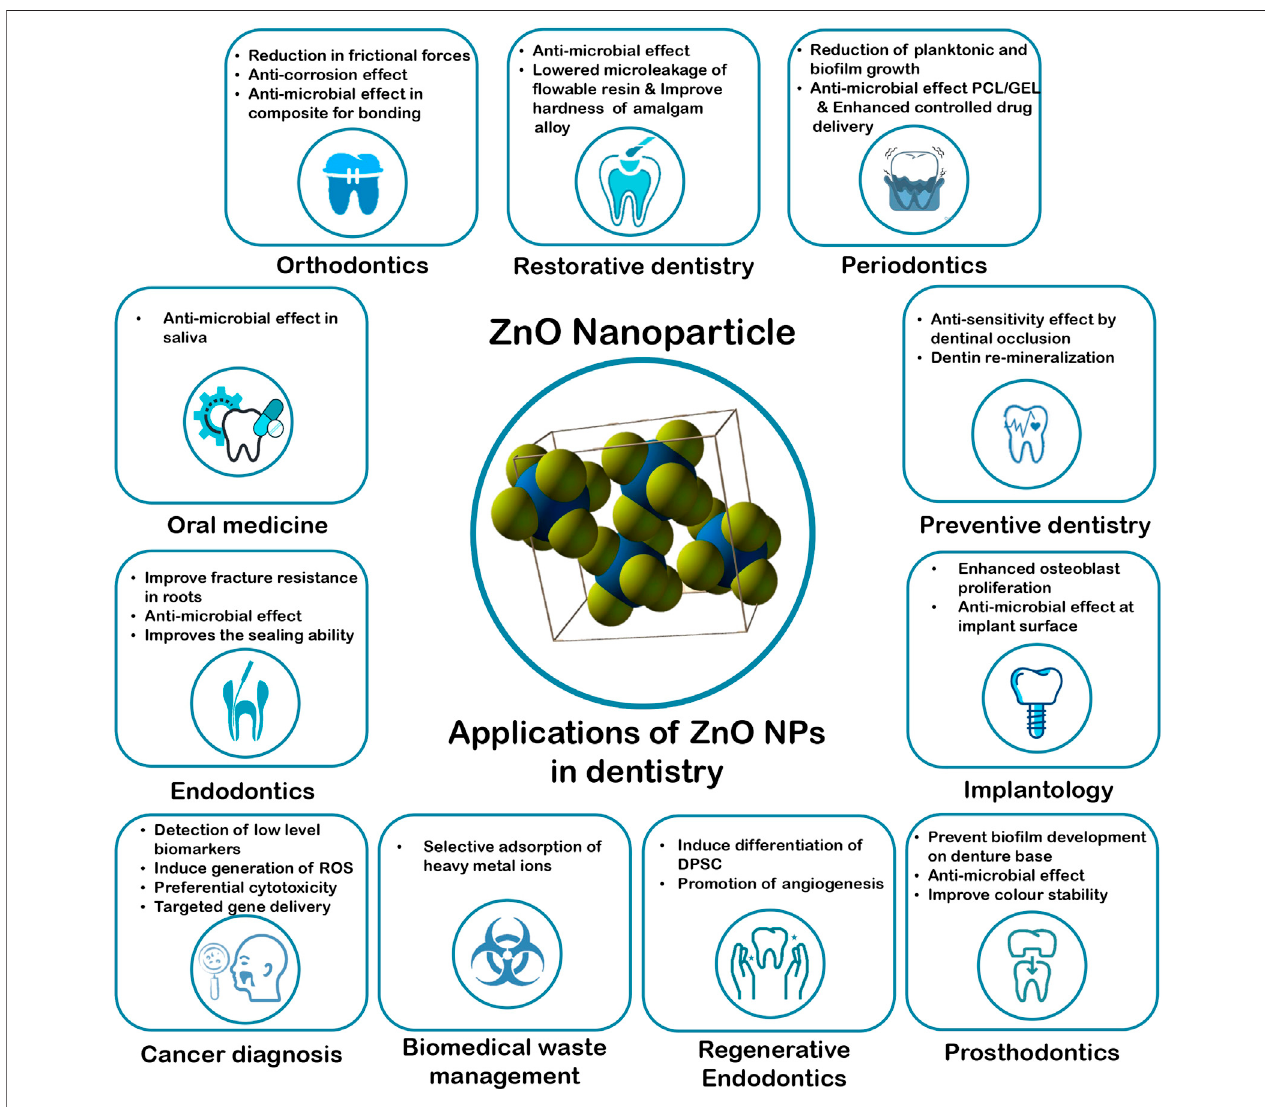
FIGURE 1 | Applications of ZnO NPs in